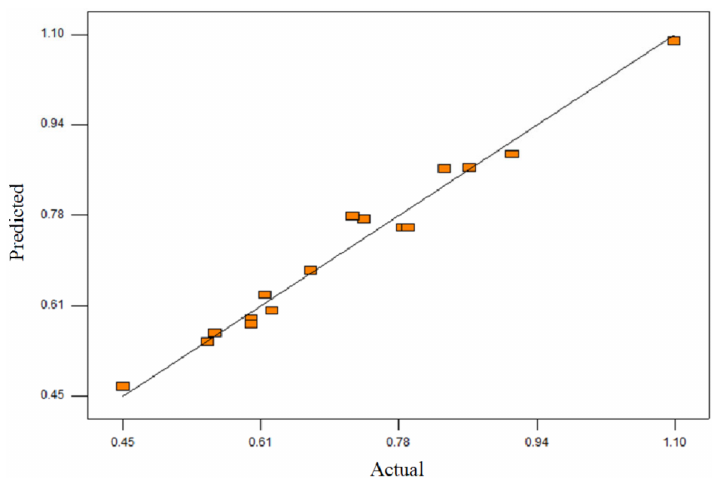
Figure 1. The plot of predicted versus actual (correlation between the predicted and actual experiment values for the DS